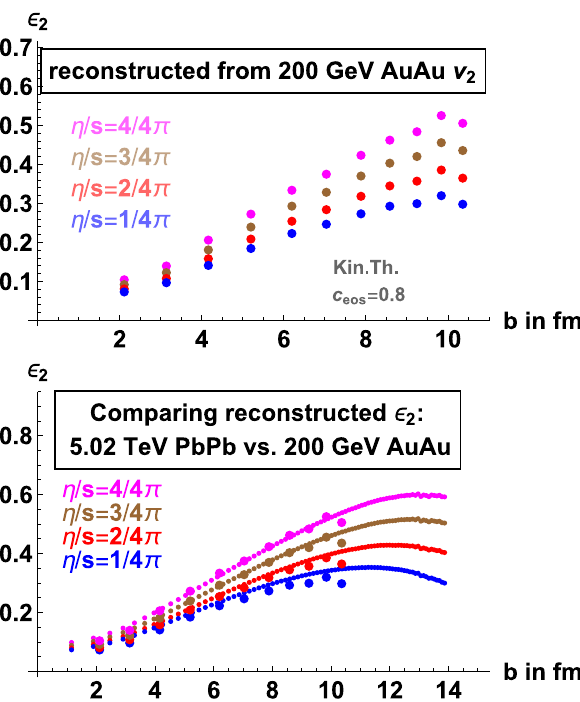
Fig. 15 The eccentricity (cid:17) 2 reconstructed for 200 GeV AuAu STAR data from (41) (upper panel) and compared to the eccentricity recon- structed from 5.02 TeV PbPb data in Fig. 14 (lower panel)